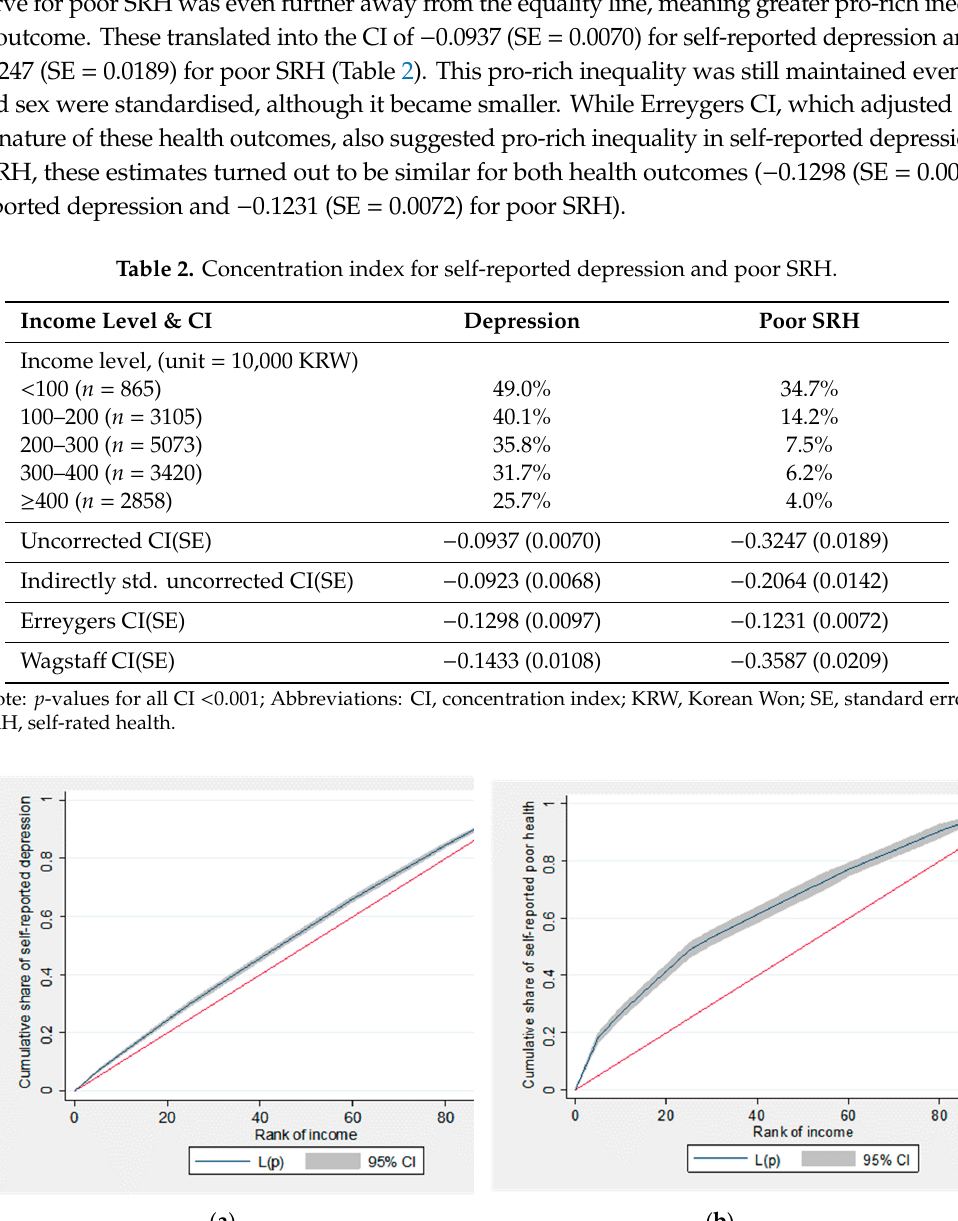
Table 3. Results of the decomposition analysis for the income-related inequality in self-reported depression and poor SRH .